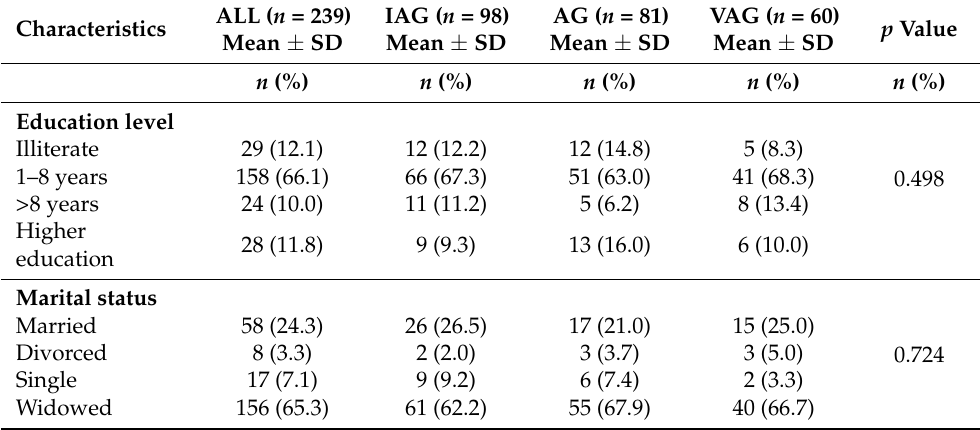
Table 1. Sociodemographic characteristics of all participants (ALL), insufficiently active (IAG), active (AG), and very active (VAG)